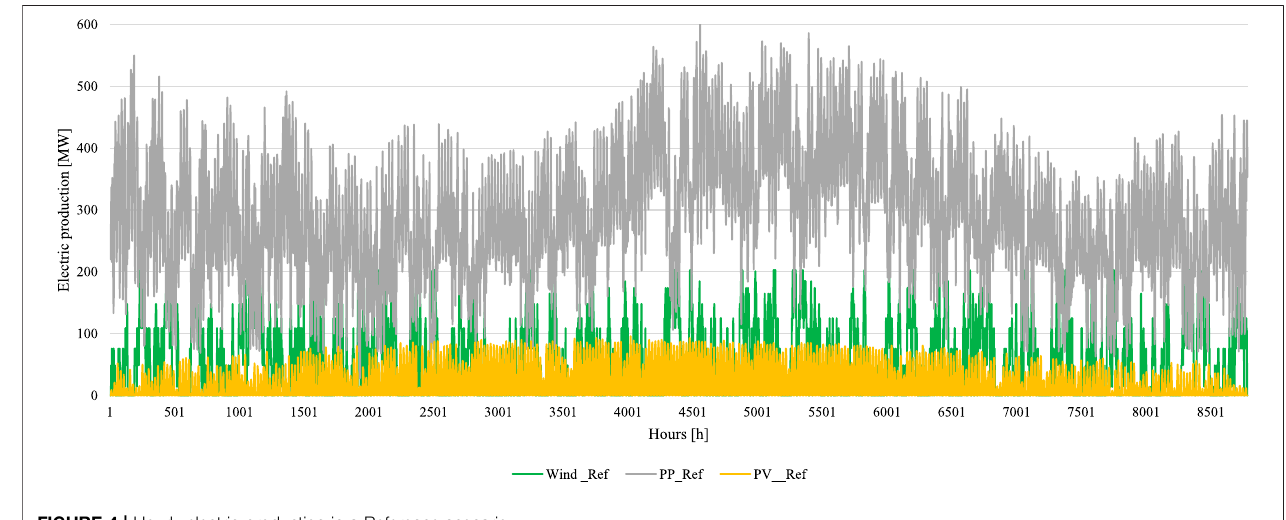
FIGURE 4 | Hourly electric production in a Reference scenario.